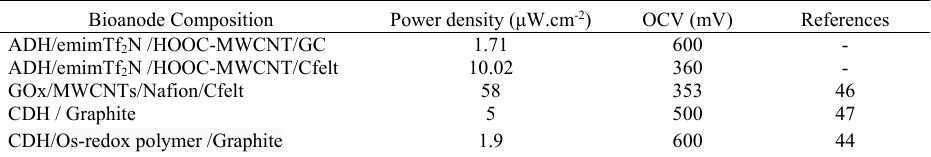
Table 1: Comparison between two electrodes that used as Bioanode Composition